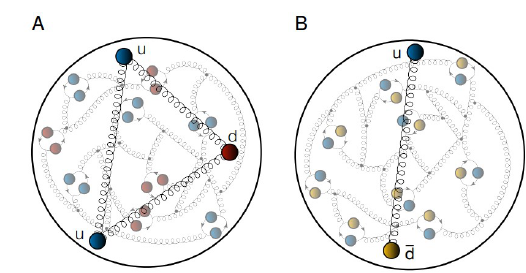
Figure 3. A . In terms of QCD’s Lagrangian quanta, the proton, p , contains two valence up ( u ) quarks and one valence down ( d ) quark; and also infinitely many gluons and sea quarks, drawn here as “springs” and closed loops, respectively. B . The pion, π + , contains one valence u -quark, one valence ¯ d -quark, and, akin to the proton, infinitely many gluons and sea